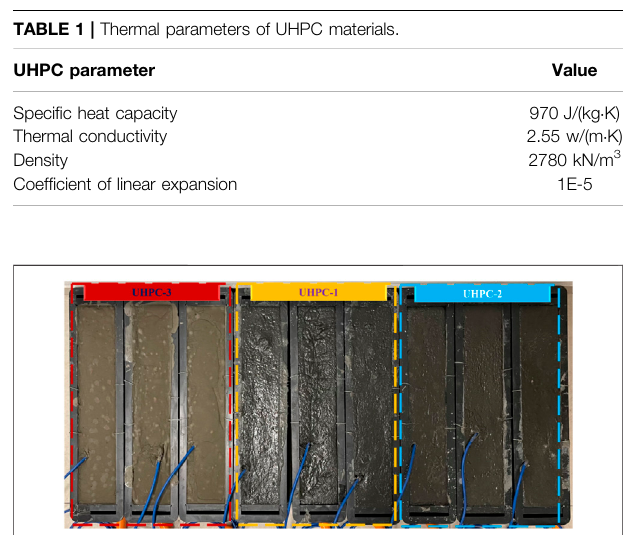
FIGURE 3 | Self-shrinking specimens.